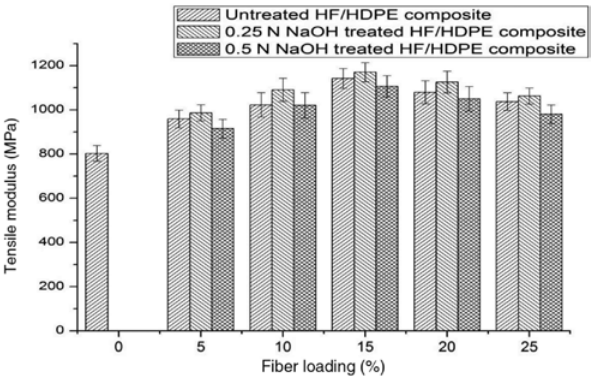
Figure 4: Effect of fiber loading on the tensile modulus of HF/HDPE- reinforced